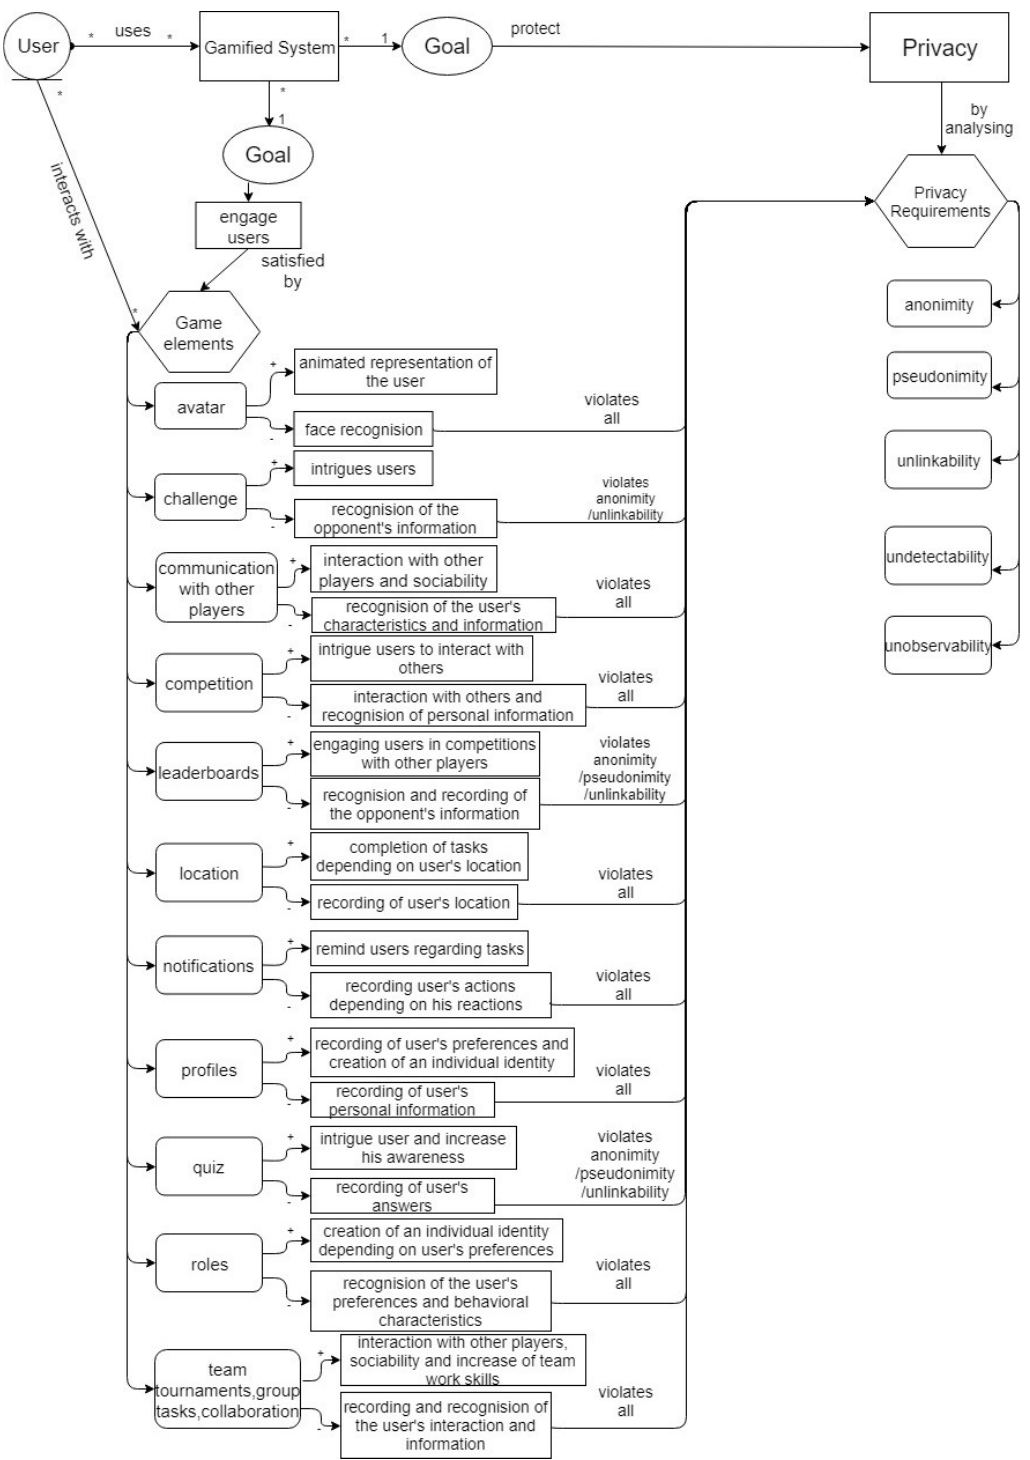
Figure 2. The interrelation of game elements and privacy requirements.